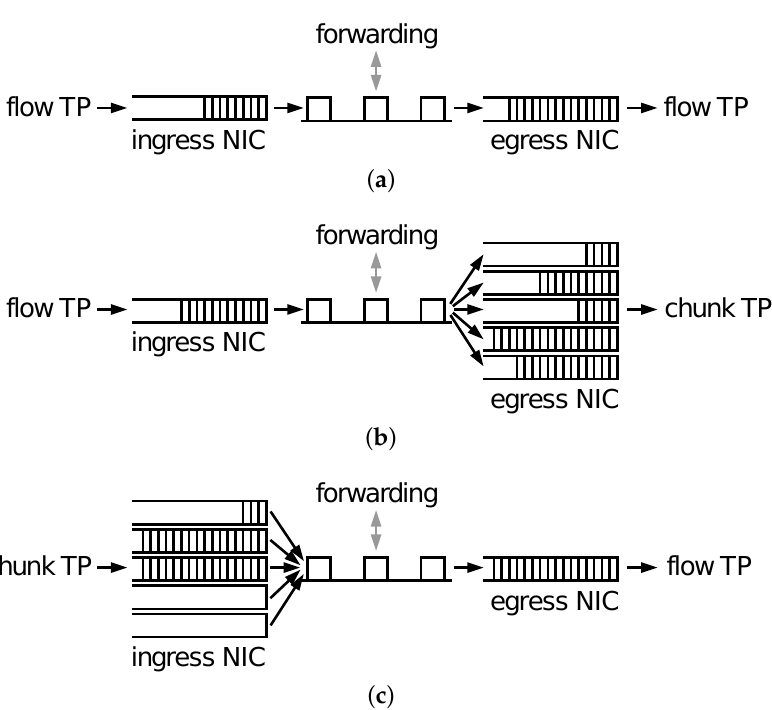
Figure 5. Linking among TPs in the JR-TS router. ( a ) Linking from flow TP to flow TP, ( b ) linking from flow TP to chunk TP, and ( c ) linking from chunk TP to flow